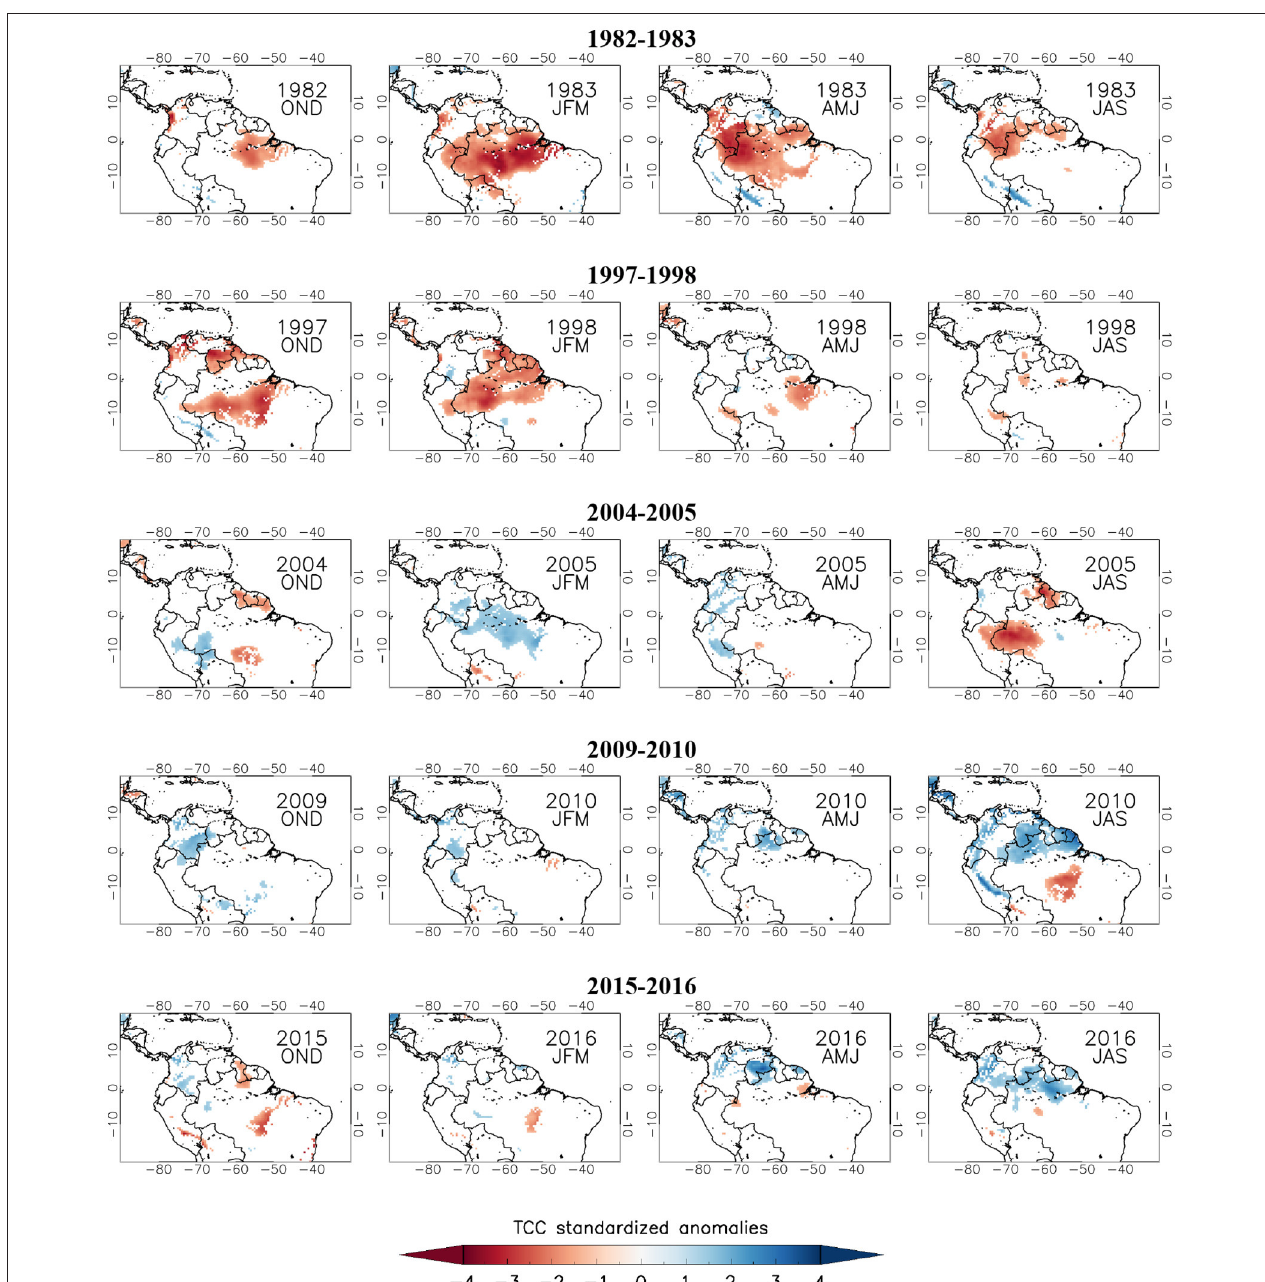
FIGURE 1 | Total cloud cover standardized anomalies over Amazonia for strong EN events in 1982–83, 1997–98, and 2015–16, as well as for moderate EN events in 2004–05 and 2009–10. For each event, standardized anomalies for the OND season of the first year are presented, and standardized anomalies for seasons JFM, AMJ and JAS of the second year, are presented. Total cloud cover product was extracted from the ERA-Interim reanalysis resampled at 0.5 ◦ × 0.5 ◦ . The reference period to compute the anomalies was 1981–2010. Results are only shown over pixels classified as Evergreen Broadleaf Forest and pixels with standardized anomalies higher than 1.28, equivalent to a confidence level of 80% ( α =